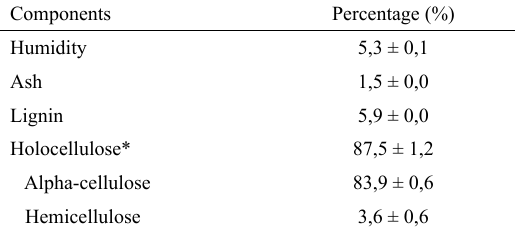
Table 1: Lignocellulosic composition of cotton linter.